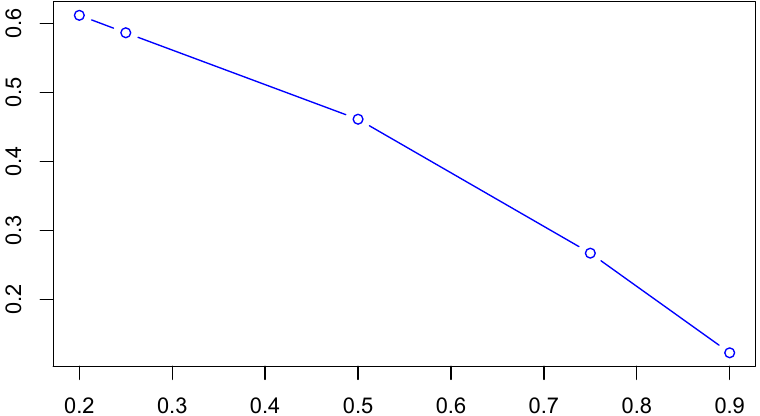
Figure 2. Approximate entropy (ApEn) of FIOU with µ = σ = 1, β = 0, as a function of α for N = 100. (Values of α are on the horizontal axes).